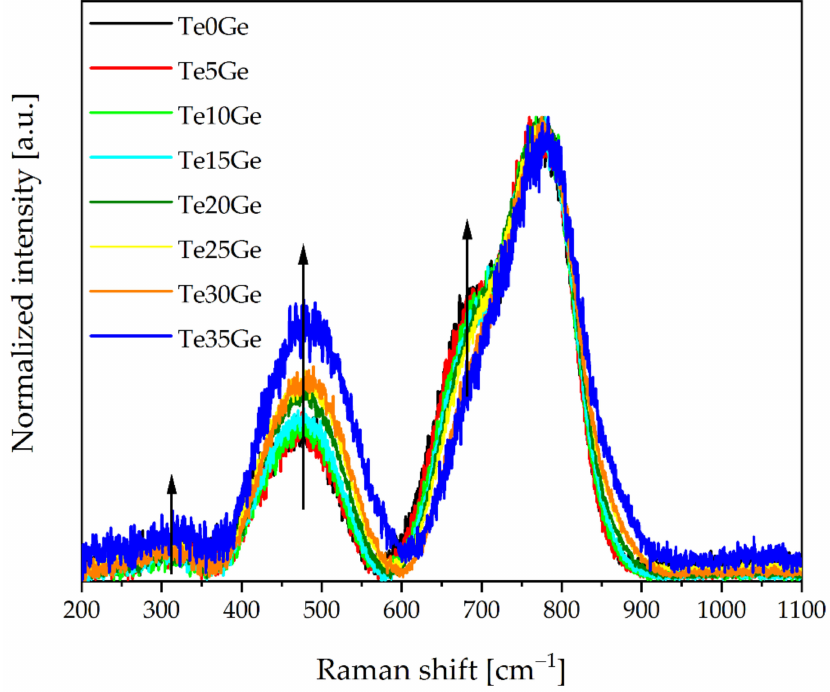
Figure 6. Raman spectra of Eu 3+ -doped glasses with various TeO 2 /GeO 2 molar